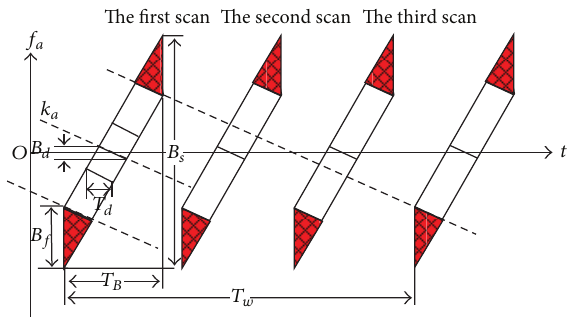
Figure 4: TFD properties of spaceborne WAS